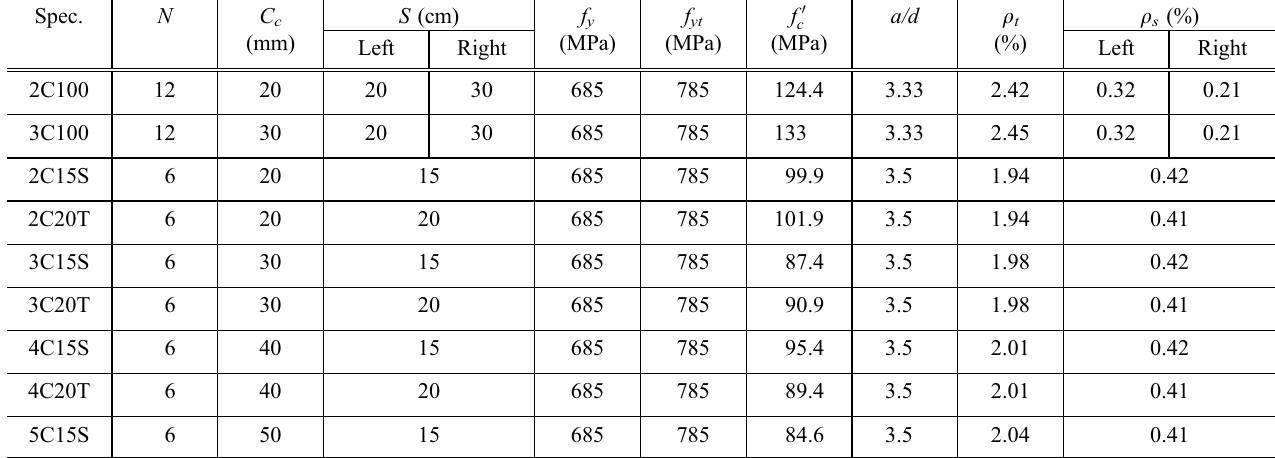
Table 2 HSRC beam specimens conducted in this